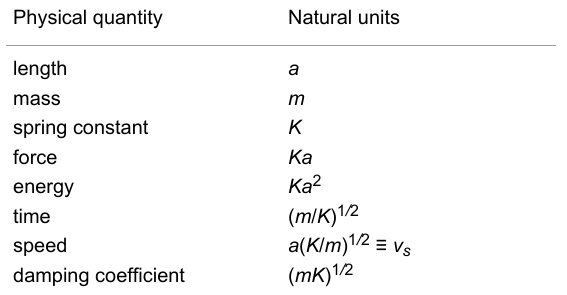
Table 1: Natural units for several mechanical quantities in the model.